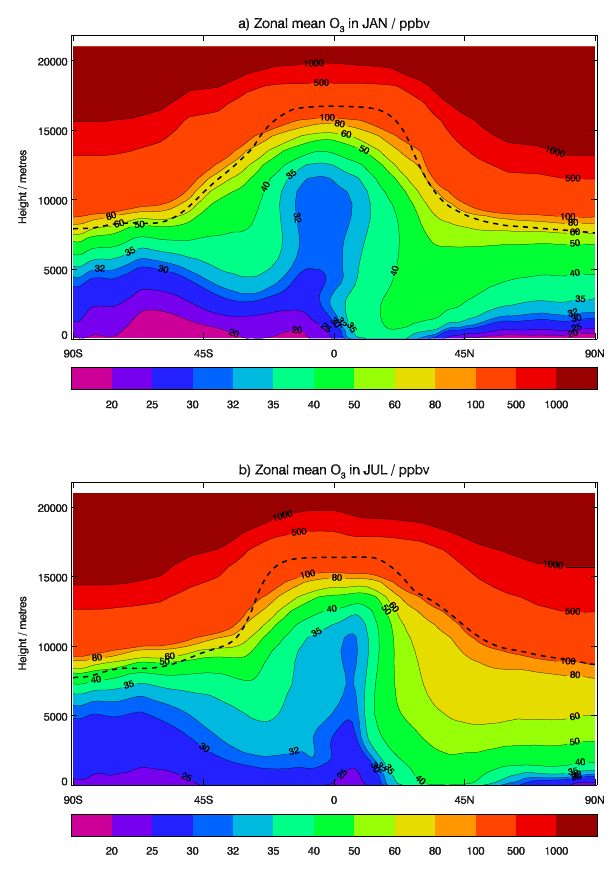
Fig. 24. Multi-annual zonal and diurnal mean O 3 distributions from the StdTrop chemistry scheme in the tropospheric configuration of the UKCA model in (a) January and (b) July. The thick dashed lines mark the position of the modelled tropopause (Hoerling et al.,